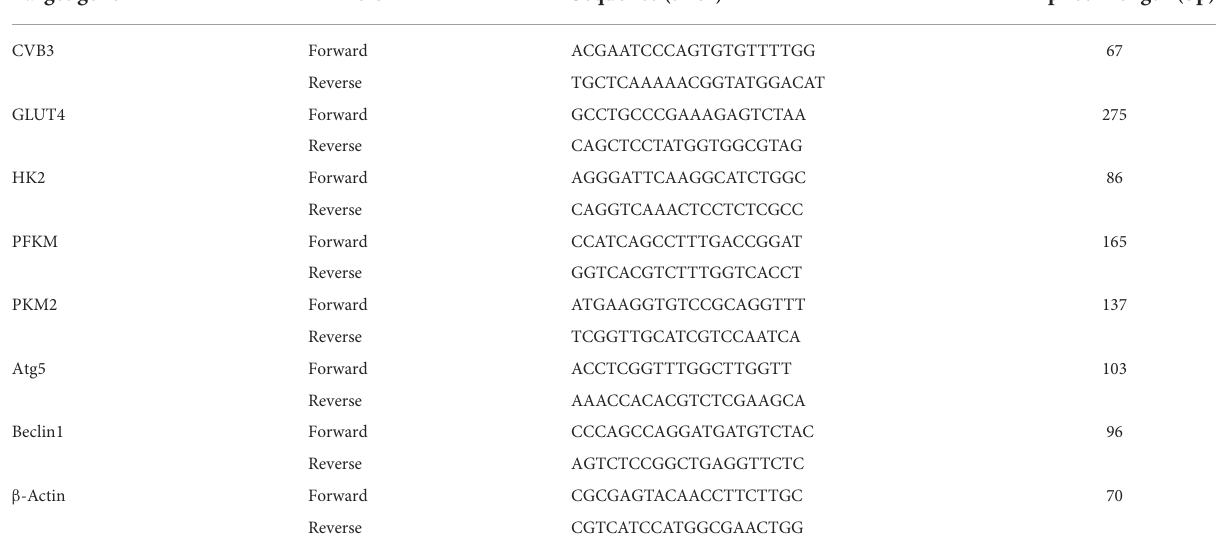
TABLE 1 Primer sequences for H9c2 rat cardiomyocytes.